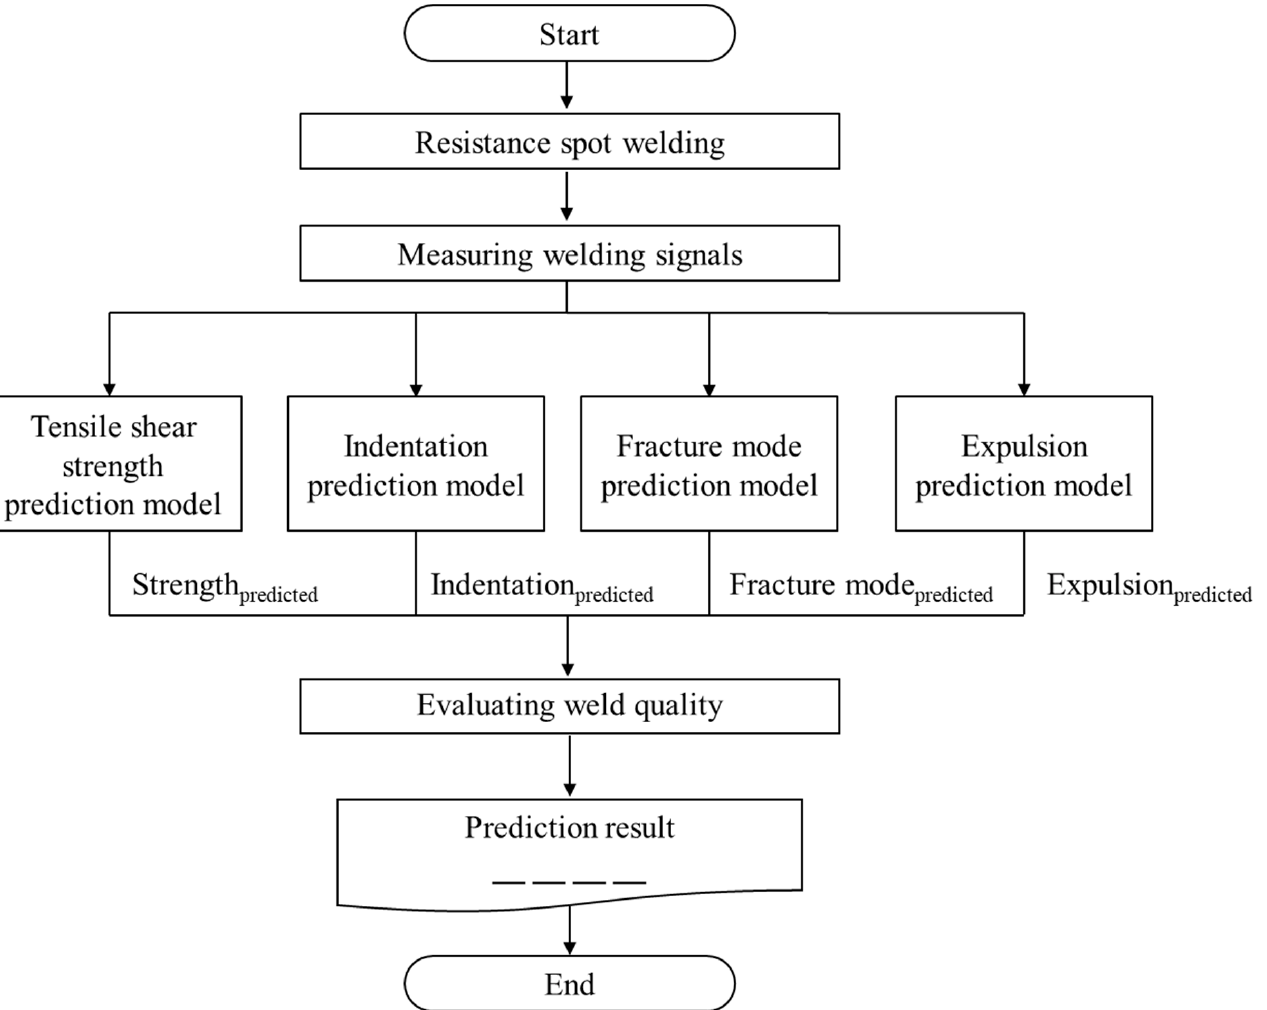
Figure 7. Flowchart for multiple model-based weld quality prediction technology.